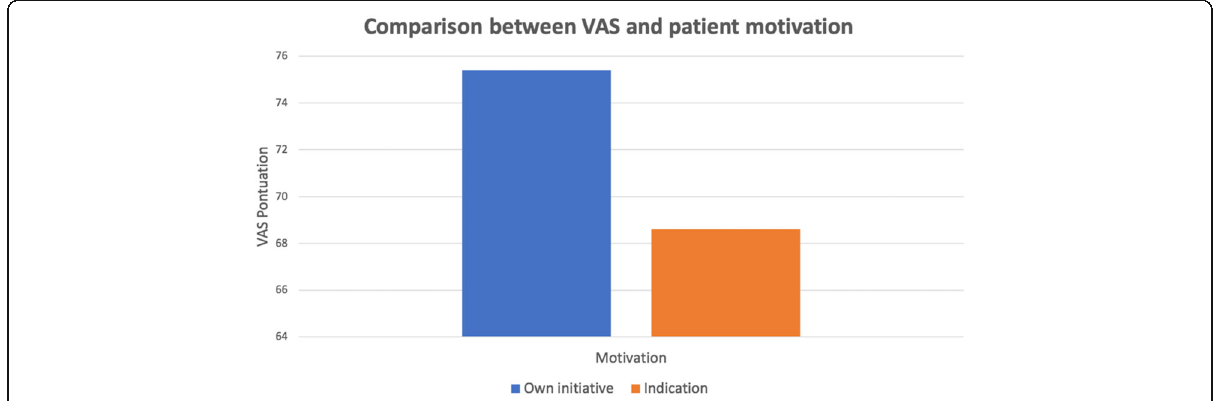
Fig. 2 Comparison between patient self-report of treatment cooperation (VAS) and patient ’ s motivation for seeking treatment ( p